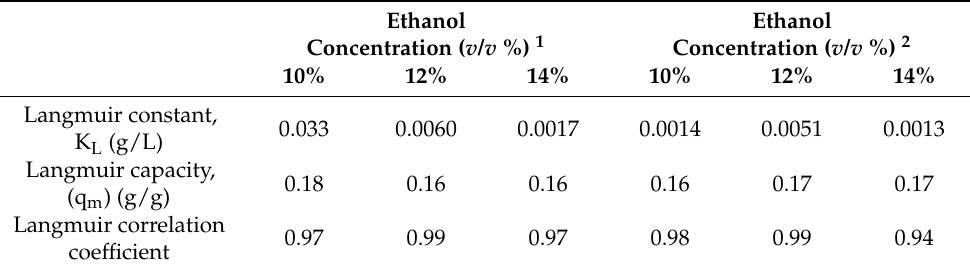
Table 3. Effect of ethanol concentration on protein adsorption and removal from model wine solutions by the ion-exchange resin Macro-Prep ®